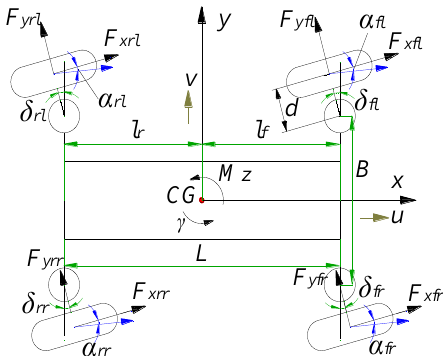
Figure 4. Simplified flexible chassis dynamics model. CG is the center of chassis gravity; l r and l f are the distances from the front and rear off-center shafts to CG, respectively; M Z represents the yaw moment generated by the four electric wheels; F xi represents the longitudinal tire force of each wheel; F yi is the lateral tire force of each wheel; and α yi is the slip angle of each wheel; γ is the yaw rate.